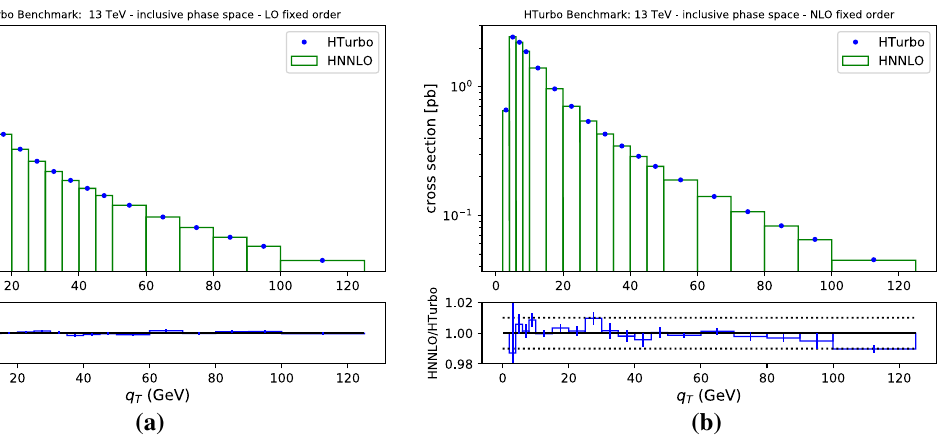
Fig. 3 Comparison of full-photon phase space differential cross sec- tions computed with HRes and HTurbo at componentofthetransversemomentumdistributionatLO( a )andNLO